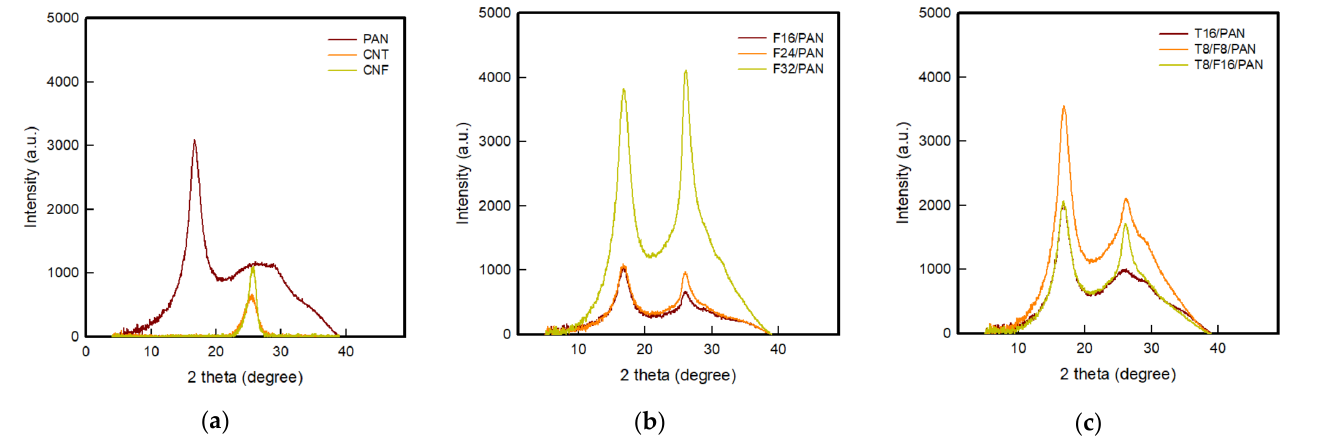
Figure 6. XRD pattern of the PAN-based conductive yarn with various contents of carbon nanomaterials ( a ) Raw materials, ( b ) CNF, and ( c ) CNT and CNT/CNF blended.